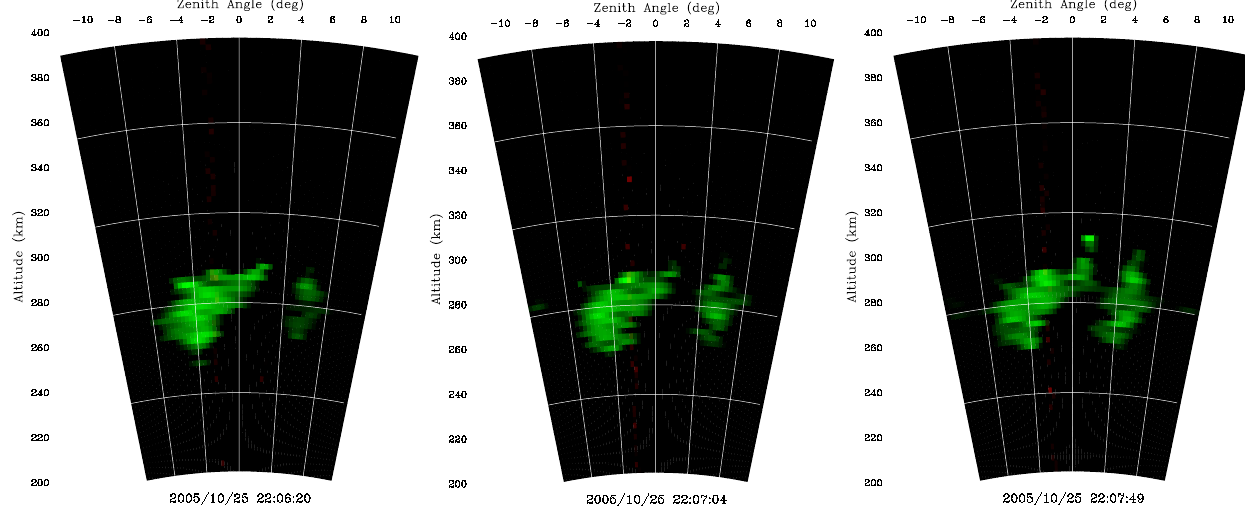
Fig. 4. Sequence of in-beam radar images showing two clusters of scatterers within the radar field-of-view.